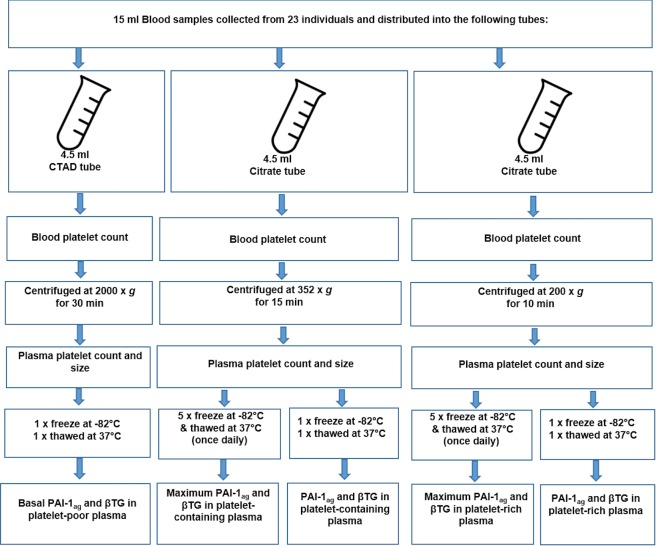
Design of follow-up study.